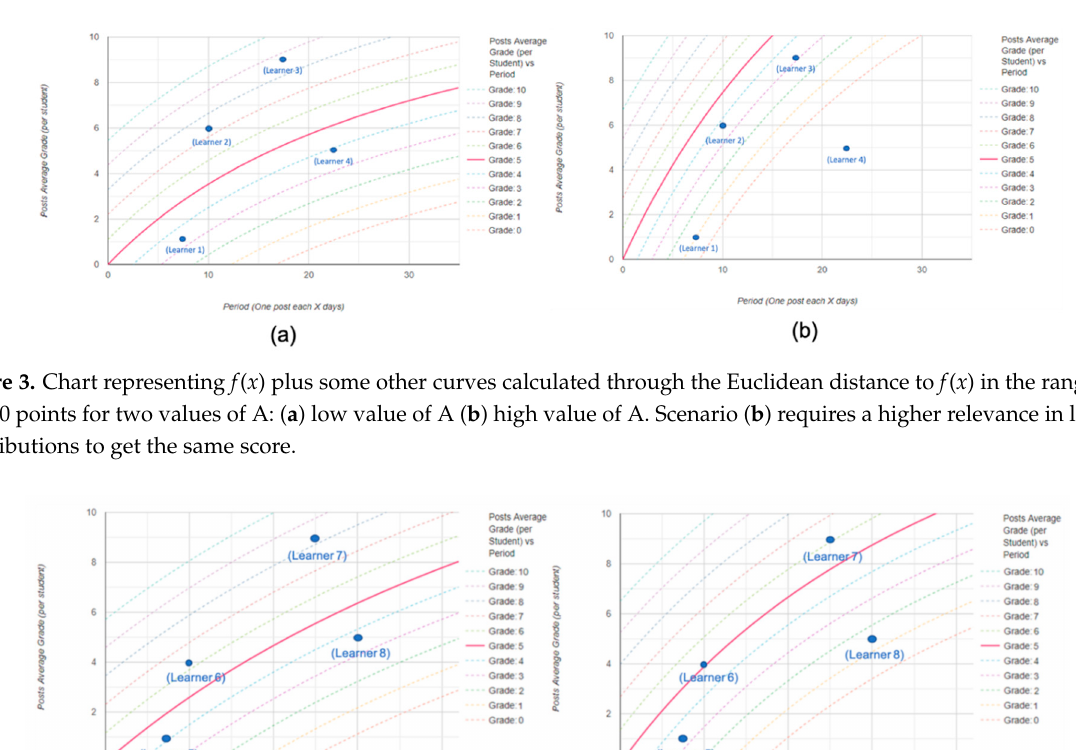
Figure 4. Chart representing f ( x ) plus some other curves calculated through the Euclidean distance to f ( x ) in th e range from 0 to 10 points for two values of B : ( a ) high value of B ( b ) low value of B . Scenario ( b ) requires a higher general interaction in the forum by the learner to get the same score.